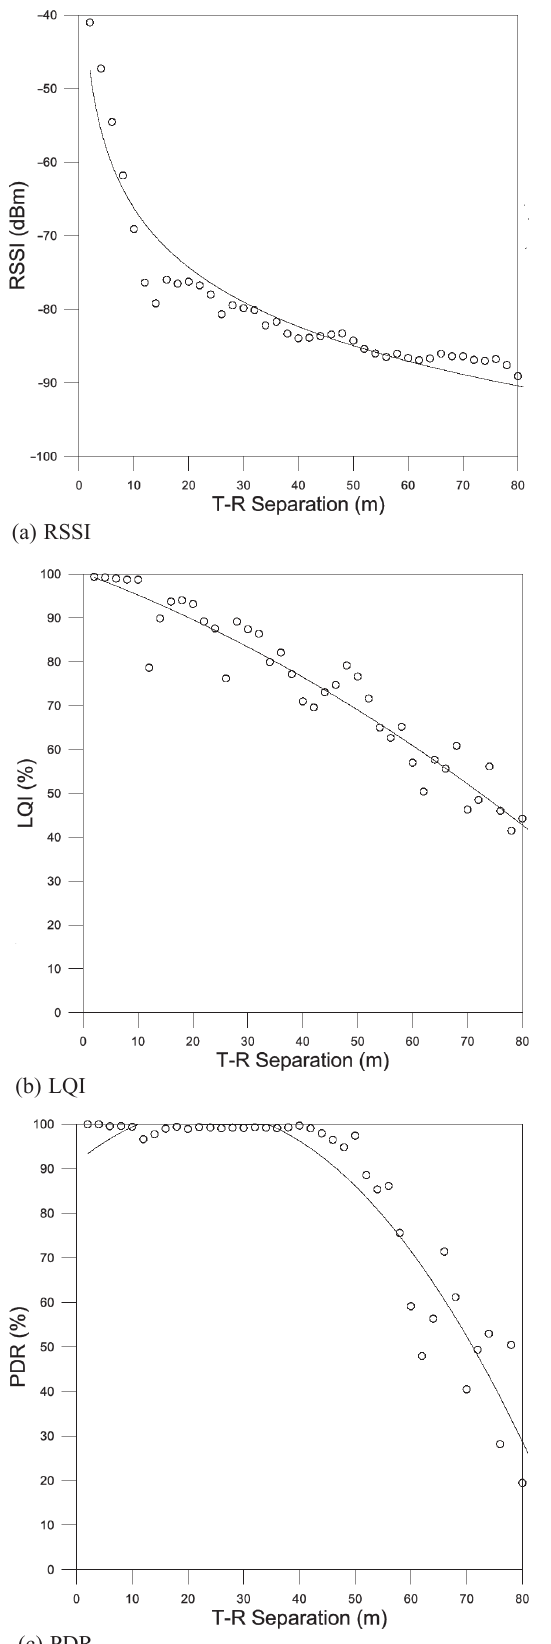
Fig. 5. Performance measurements in an obstructed